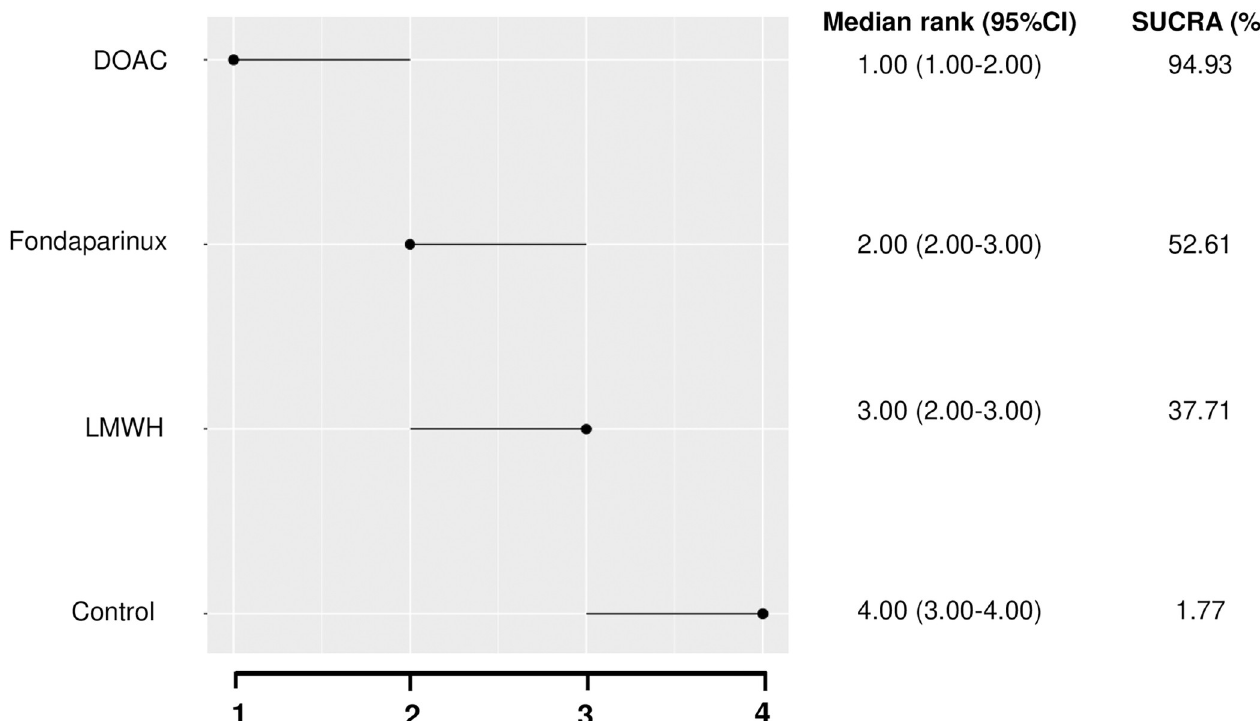
Fig 5. Median rank and SUCRA values of competing prophylactic treatments. DOAC, direct oral anticoagulant; LMWH, low molecular weight heparin; SUCRA, surface under the cumulative ranking curve.